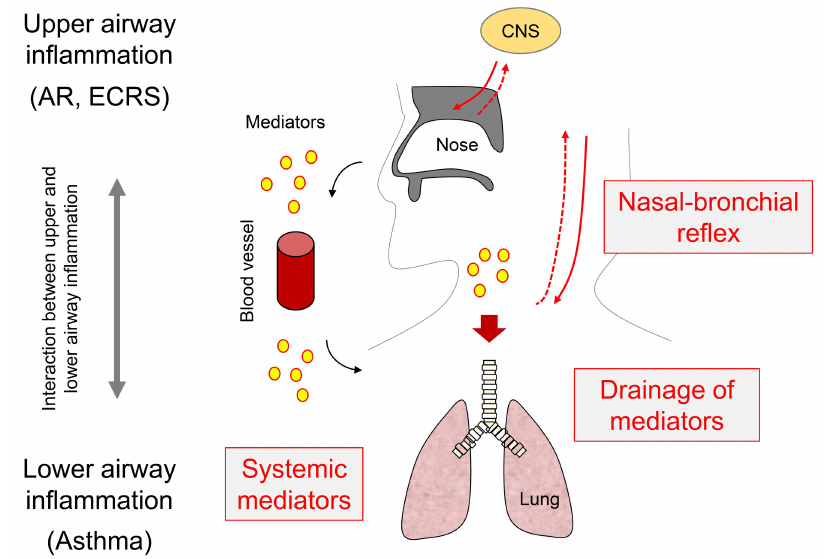
Figure 1. Schema of mechanisms of interaction between upper and lower airway inflammation. Red line and dot-line indicate parasympathetic and trigeminal nerve, respectively. AR, allergic rhinitis; CNS, central nervous system; ECRS, eosinophilic chronic